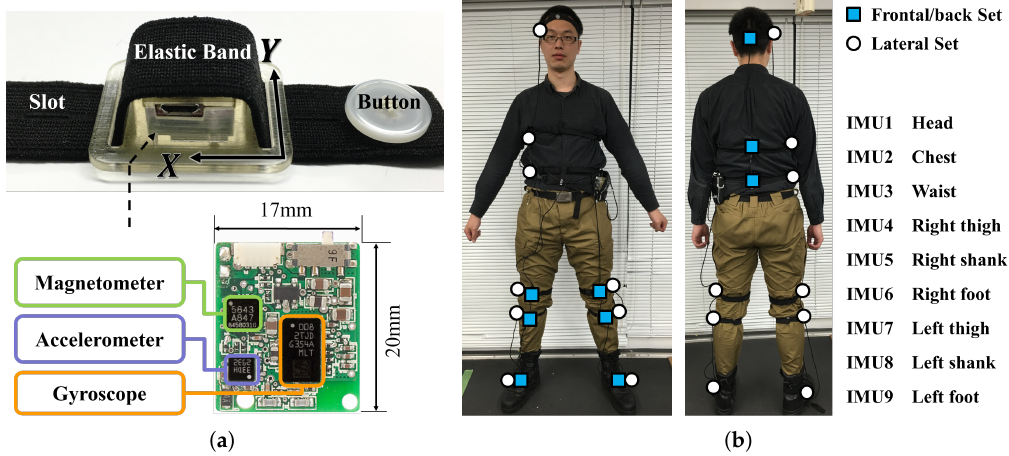
Figure 4. Sensor system. ( a ) WB-4R Inertial Measurement Unit (IMU); ( b ) Sensor placement. The yellow circles represent the Frontal/back Set, which was attached to the frontal side of lower limbs and the back side of trunk and head. The white circles represent the Lateral Set, which was attached to the lateral side of the